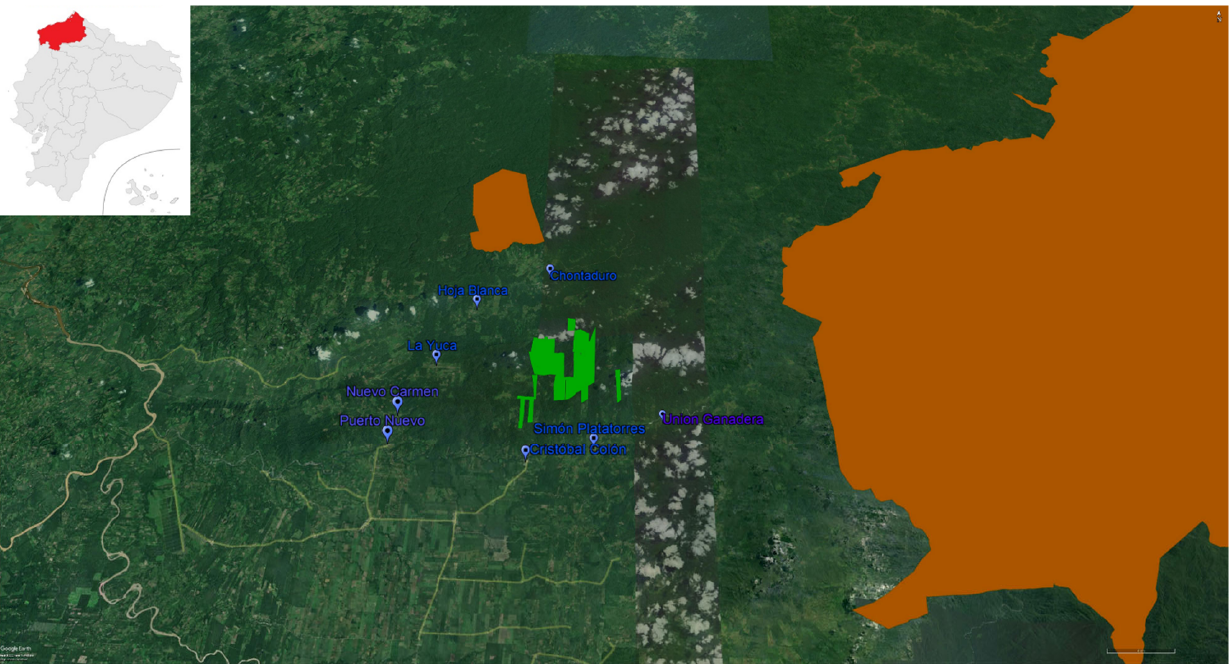
Figure 1. Location of the Tesoro Escondido Reserve. In light green is the Tesoro Escondido Re ‐ serve, in blue are the local communities where environmental education has taken place, and in orange are national protected areas (Pambilar Wildlife Refuge to the north and Cotacachi Cayapas National Park to the East).